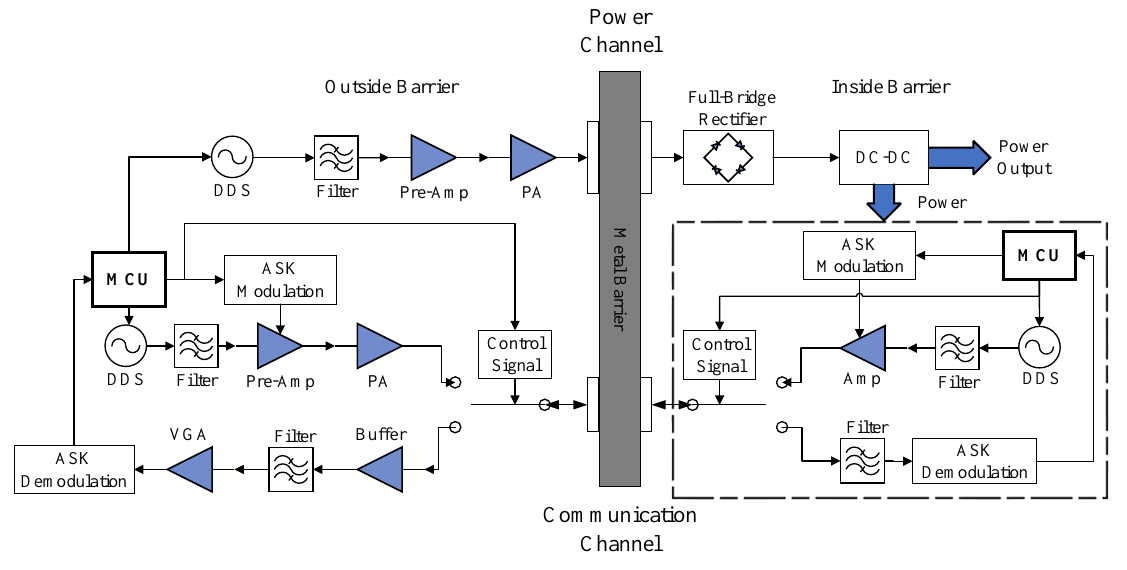
Figure 8. Block diagram of circuits for simultaneous transfer of power and data through